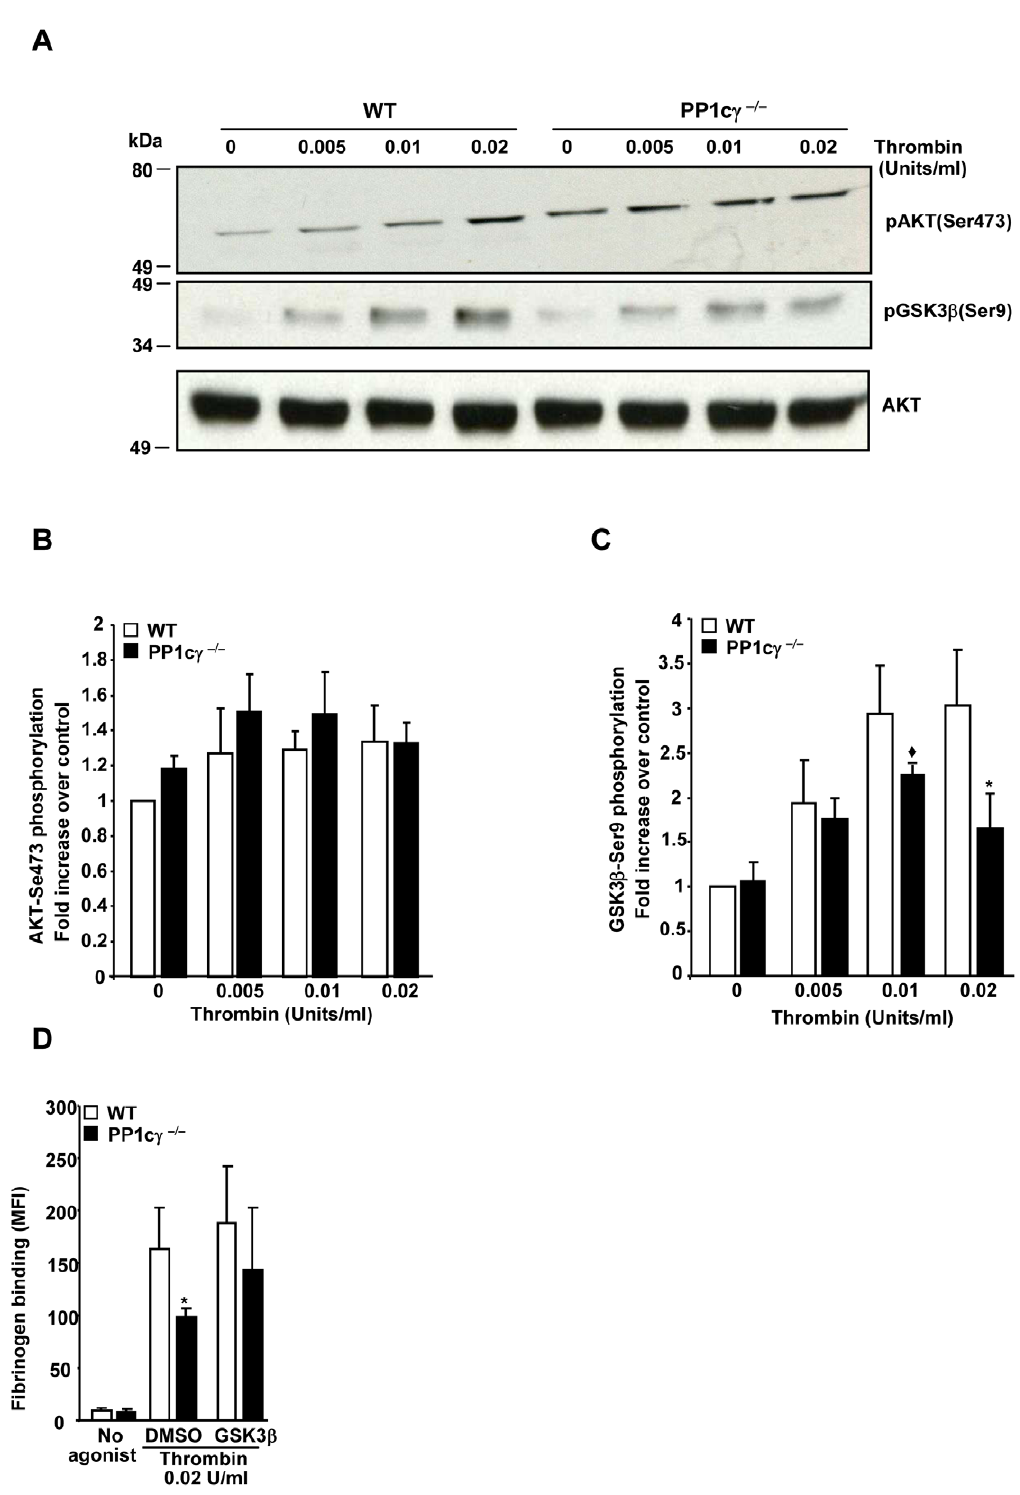
Figure 6. Decreased phosphorylation of GSK3 b -Ser9 in thrombin stimulated PP1c c 2 / 2 platelets. ( A ). Platelet lysate from resting (0) and thrombin activated (0.005, 0.01 and 0.02 U/ml) was separated on an SDS-PAGE and immunoblotted with antibodies to AKT-Ser473, GSK3 b - Ser9 and AKT (total). ( B and C ) Densitometric quantification of phosphorylation levels for AKT-Ser473 and GSK3 b -Ser9 in WT and PP1c c 2 / 2 stimulated platelets. The decreased phosphorylation of GSK3 b -Ser9 in thrombin-stimulated PP1c c 2 / 2 platelets was significant at ¤ p=0.05 (for 0.01 U/ml thrombin); *p=0.02 (for 0.02 U/ml thrombin). Data are expressed as 6 SEM of 5 experiments. ( D ) Effect of GSK3 b inhibitor VIII on thrombin-induced fibrinogen binding on WT and PP1c c 2 / 2 platelets. Compared with WT platelets, PP1c c 2 / 2 platelets displayed , 40% decreased fibrinogen binding in response to 0.02 U/ml thrombin in the presence of solvent control (DMSO) (*P=0.048) and GSK3 inhibitor VIII (GSK3 b ) partially reduced the difference to 23%. Data are expressed as 6 SEM of 3–4 experiments.